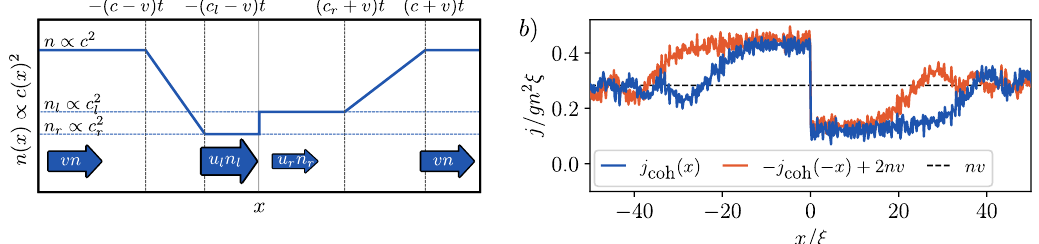
Figure 6: a) Qualitative sketch of the density profile (i.e. local speed of sound) at a dissipative point contact in a constant background current vn , within the linear response regime. The size of the blue arrows indicates the strength of the current at their position. b) Simulation of the coherent current in the linear response regime ( σ = 0.2 gn ξ , v = 0.2 c and t = 20 / gn ). The two lines agree close to the contact, since it induces equally strong currents on both